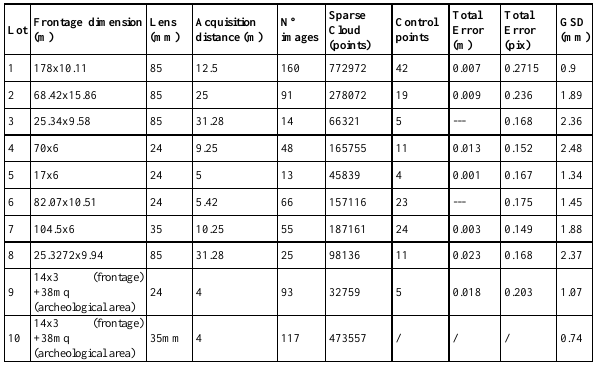
Table 2. Photogrammetry 3D model data.